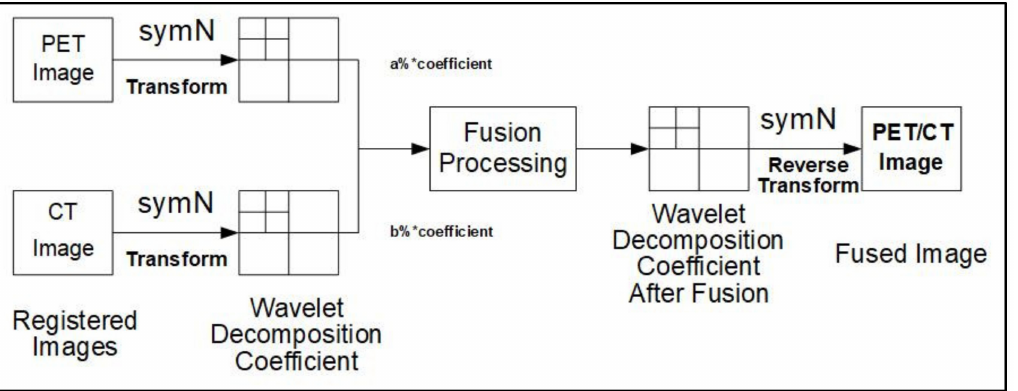
Figure 2. The symN wavelet fusion process for PET/CT